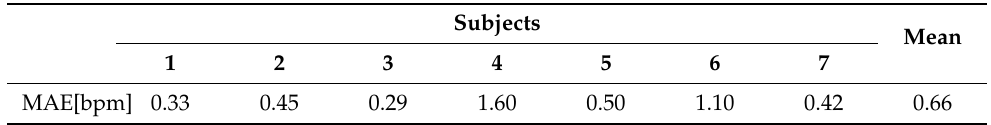
Table 2. RR estimation result: This shows the MAE of the RR between the prediction and the ground